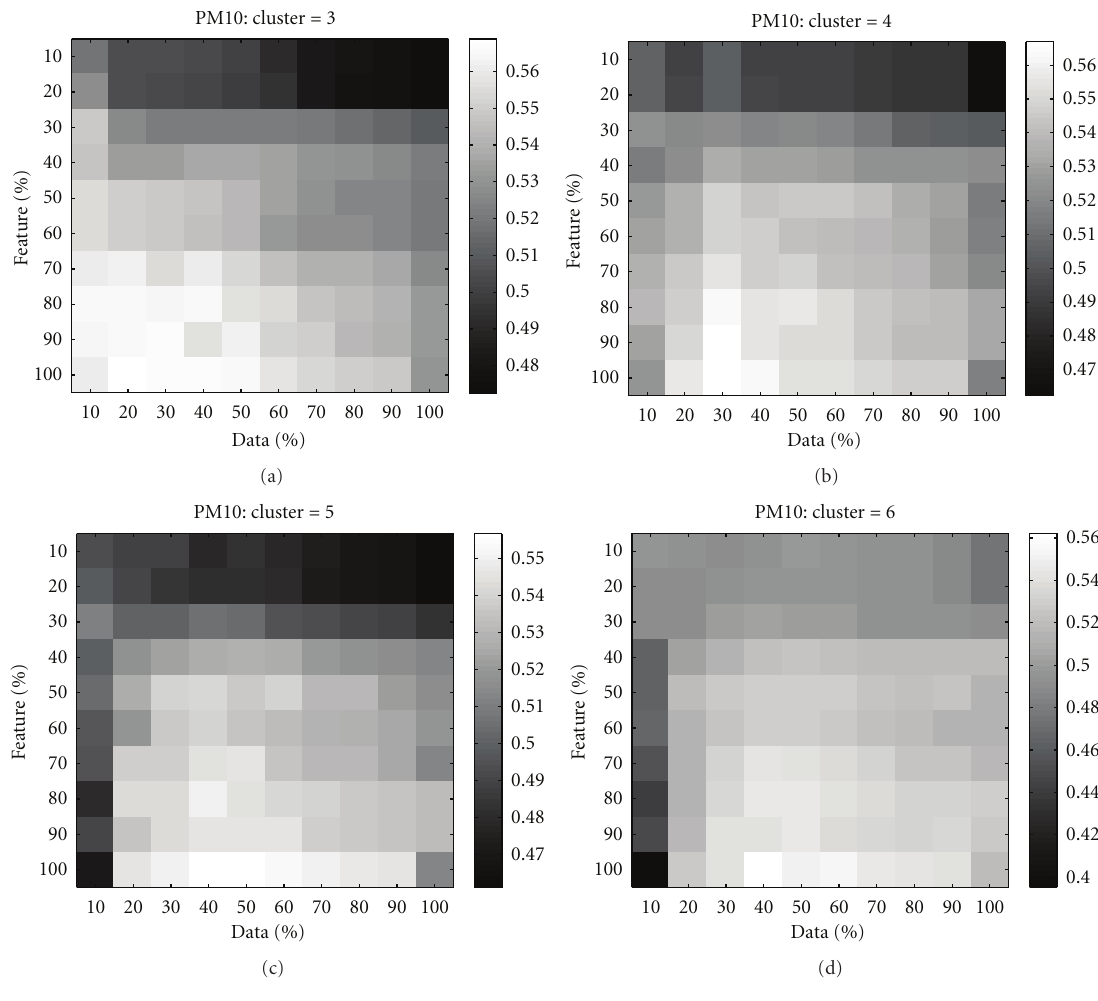
Figure 6: Heat map for PM 10 data for c varying in-between 3 to